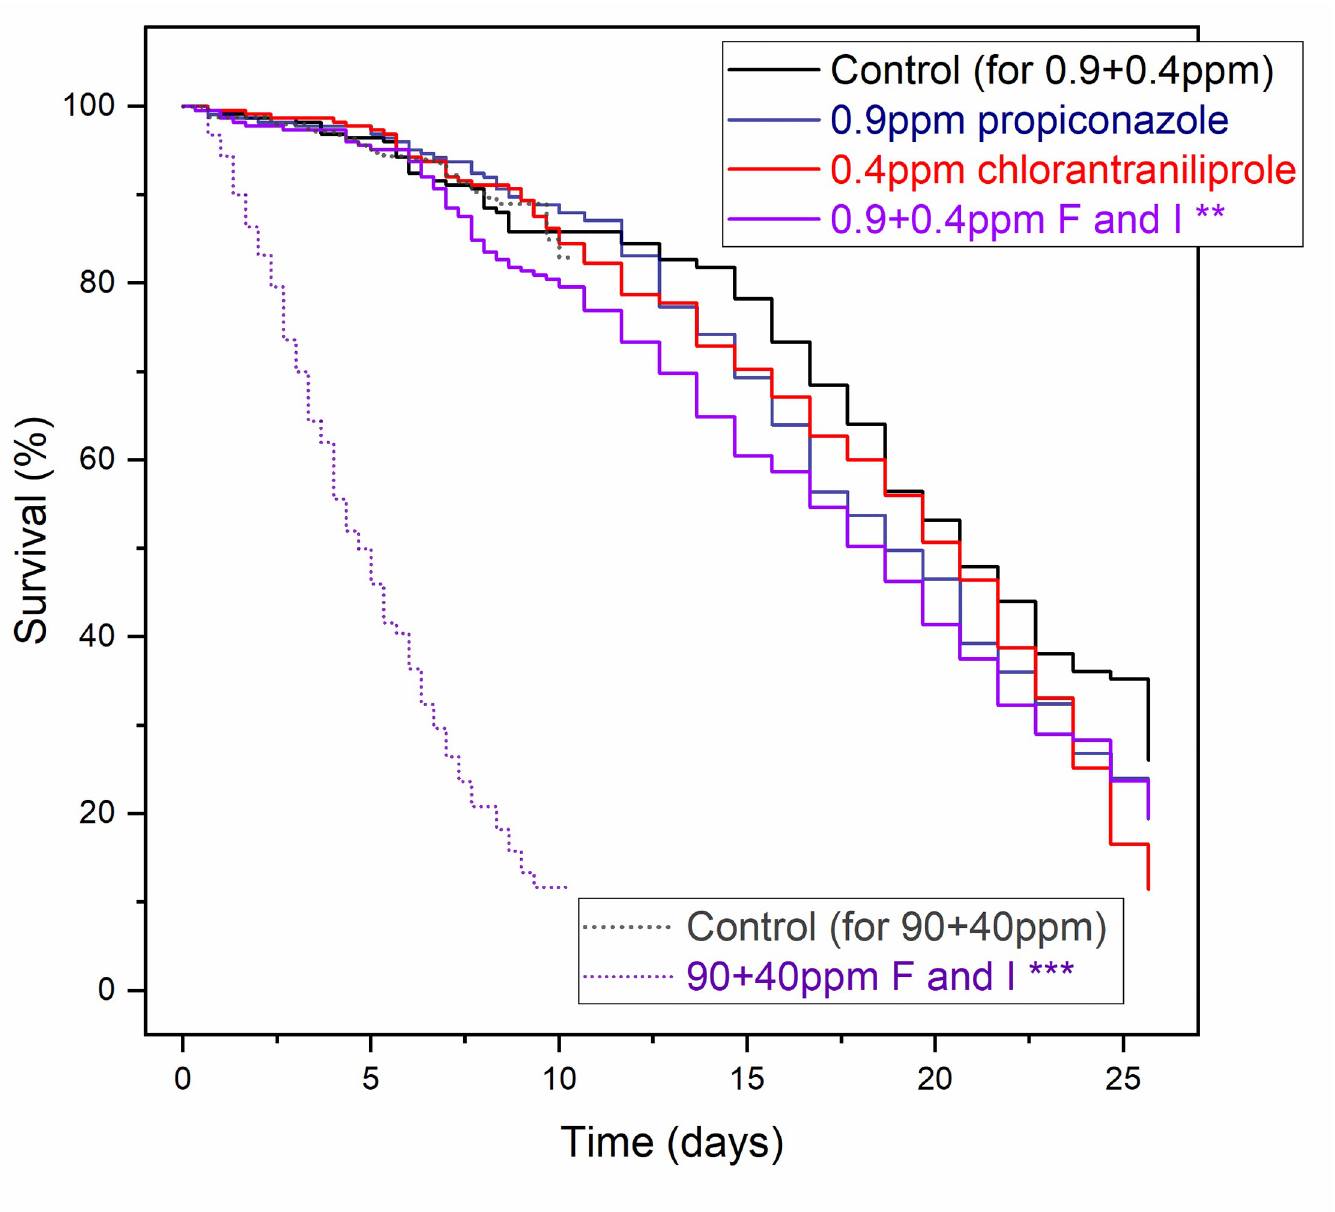
Fig 3. Kaplan–Meier survival curves of honey bees on tank-mix ratio pesticide treatments. Honey bees were fed with low [0.9 ppm propiconazole (blue solid line), 0.4 ppm chlorantraniliprole (red solid line), and 0.9 ppm propiconazole + 0.4ppm chlorantraniliprole (purple solid line)] or high [90 ppm propiconazole + 40 ppm chlorantraniliprole(purple dashed line)] concentrations of tank-mixed pesticides. Bees consuming combinations of pesticides experienced reduced longevity relative to bees consuming unamended control diet and relative to bees consuming chlorantraniliprole or propiconazole alone (F: fungicide propiconazole, I: insecticide chlorantraniliprole; n = 900 in 0.9+0.4 ppm and 500 in 90+40ppm subgroup, ��� = p < 0.001, �� = p < 0.01, Tarone-Ware test between the treatment and control).